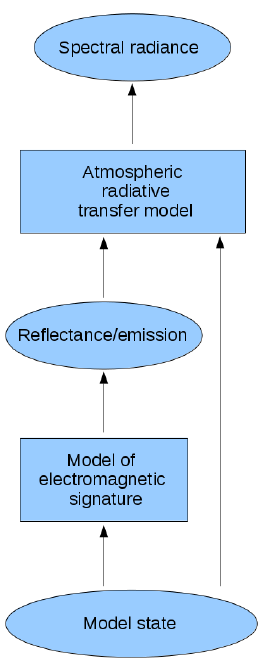
Figure 3. Generic scheme of an observation operator for spectral radiance. Oval boxes denote data, and rectangular boxes denote pro-